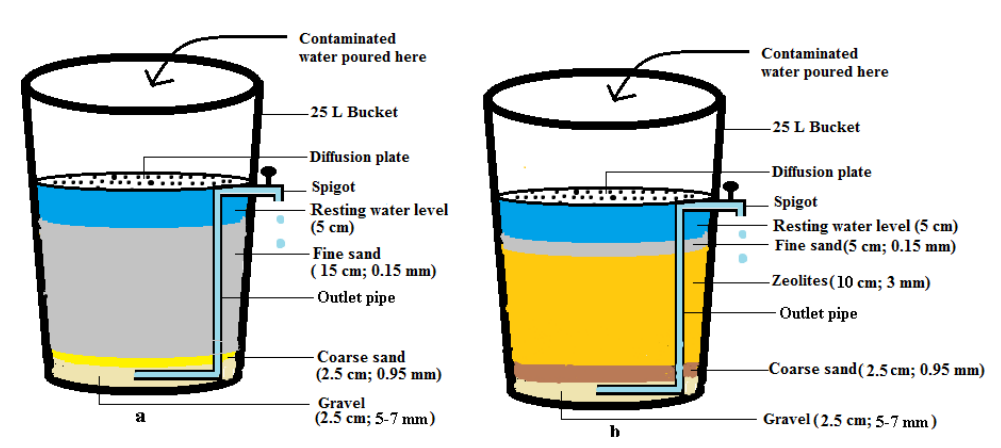
Figure 1. Schematic diagram of biosand filter designs: ( a ) biosand filter-standard, ( b ) biosand filter-zeolite. The figures between brackets are the diameter of grains of